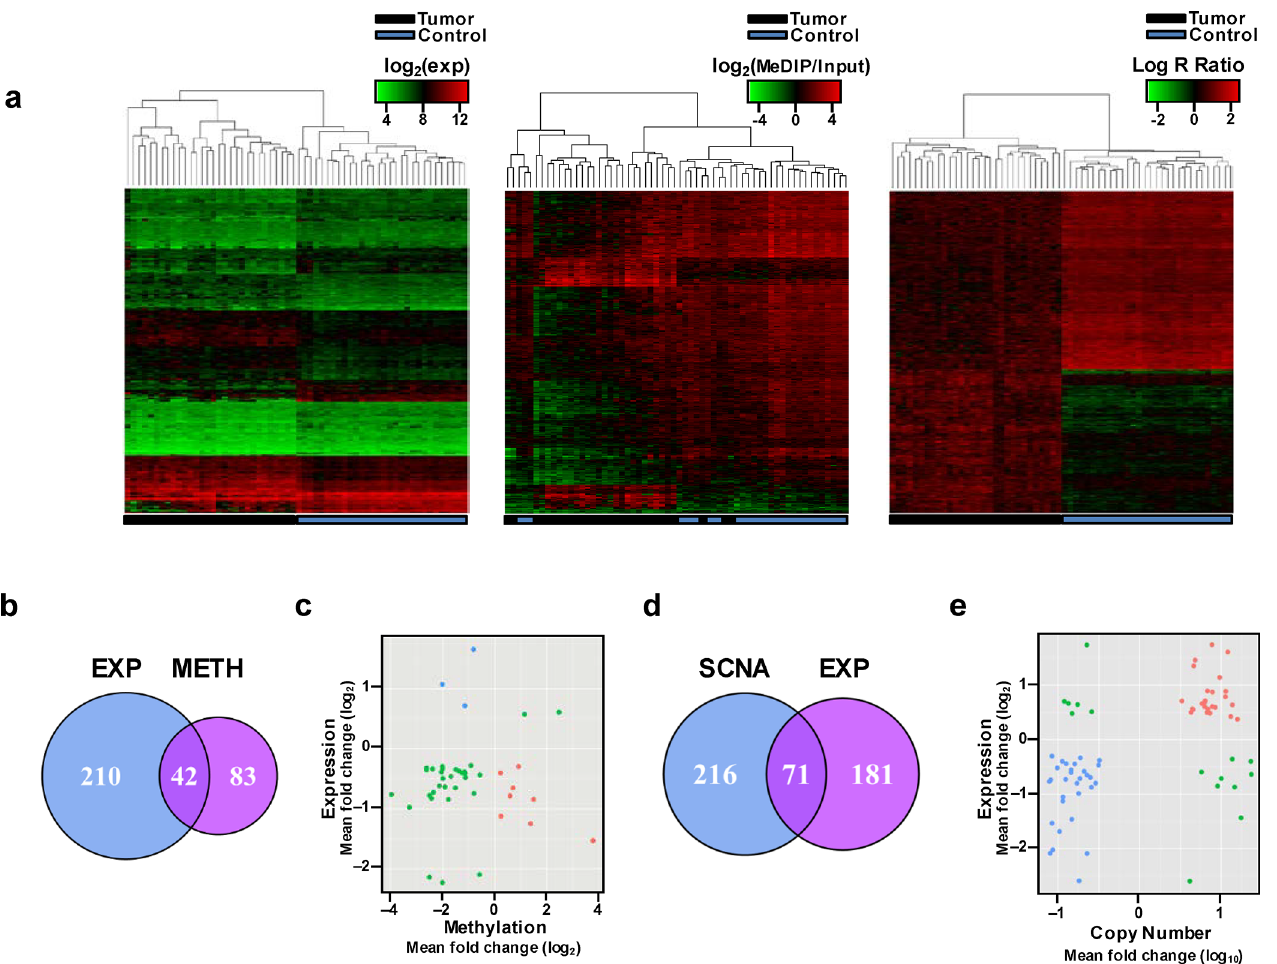
Fig 1. Identification of inflammation-related genes exhibiting coordinative changes between mRNA expression and DNA methylation or SCNA in HBV-related HCCs. (a) Hierarchical clustering with 260 significant transcripts corresponding 252 genes ( left ), 464 significant methylation probes covering 125 genes ( middle ), or 1,246 significant SNP/CN probes covering 287 genes ( right ) across HCCs (Tumor) and paired non-tumor tissues (Control). (b) Venn diagram showing 42 overlapping genes identified by the analysis of both mRNA expression and DNA methylation. EXP, genes with aberrant expression; METH, genes with aberrant DNA methylation. (c) Starburst plot of 42 overlapping genes identified by the analysis of both gene expression and DNA methylation. Red, blue and green dots indicate the genes hypermethylated and down-regulated, the genes hypomethylated and up-regulated and the genes having their expression not associated with DNA methylation, respectively. (d) Venn diagram showing 71 overlapping genes identified by the analysis of both mRNA expression and SCNA. EXP, genes with aberrant expression; SCNA, genes with copy number aberration. (e) Starburst plot of 71 overlapping genes identified by the analysis of both mRNA expression and SCNA. Red, blue and green dots indicate the genes with copy number gain and up-regulated expression, the genes with copy number deletion and down-regulated expression and the genes having inverse relationship between SCNA and mRNA expression,